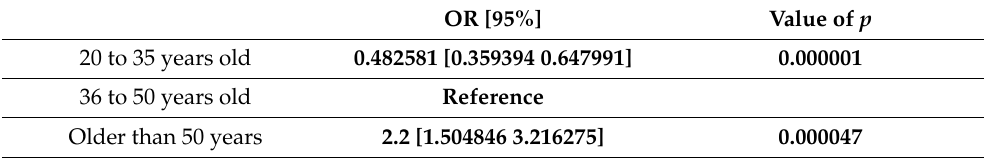
Table 13. Odds ratios of total fear symptoms and age groups.